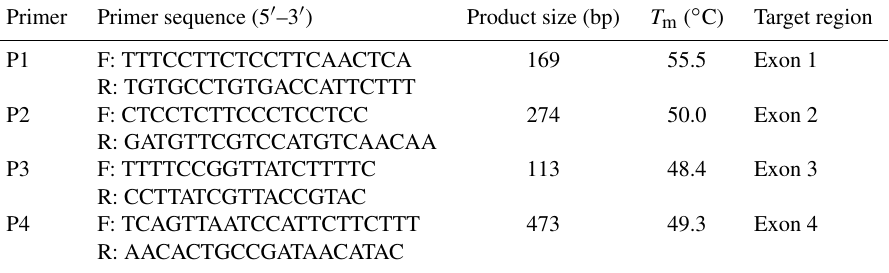
Table 1. Primers used for detecting mutations of Nanog gene in cattle Primer Primer sequence (5 (cid:48) –3 (cid:48) ) Product size